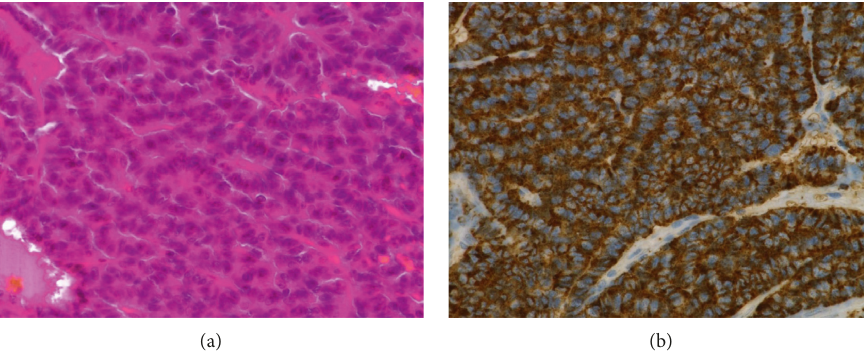
Figure 1: Histologic examination of surgically resected pulmonary carcinoid tumor shows finely granular nuclear chromatin, eosinophilic cytoplasm, and rosette formation (a) and positive expression of chromogranin A (b).